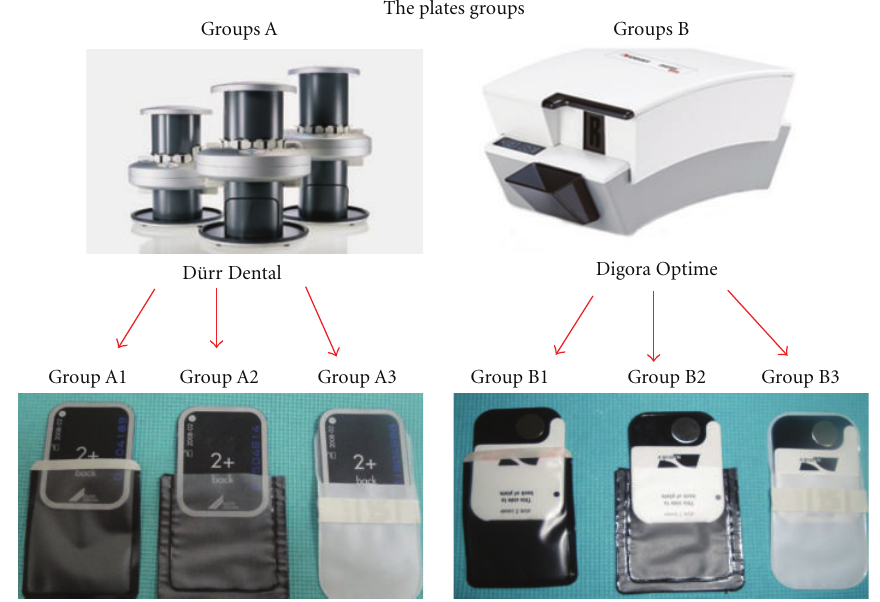
Figure 1: The two main groups (A and B) and three subgroups (1, 2, and 3) for the present